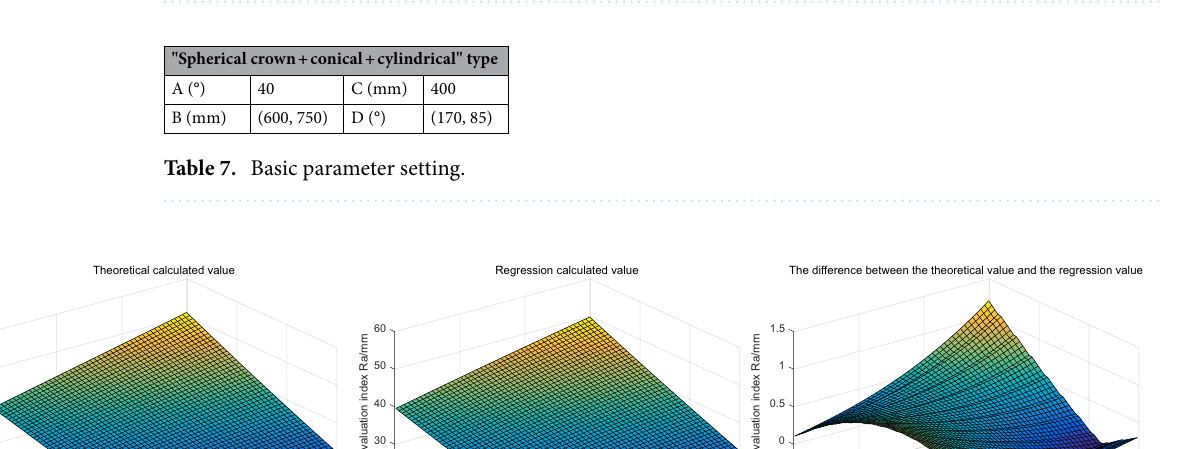
Figure 13. The influence of different cut feed rate and cut head crown radius on the evaluation index.